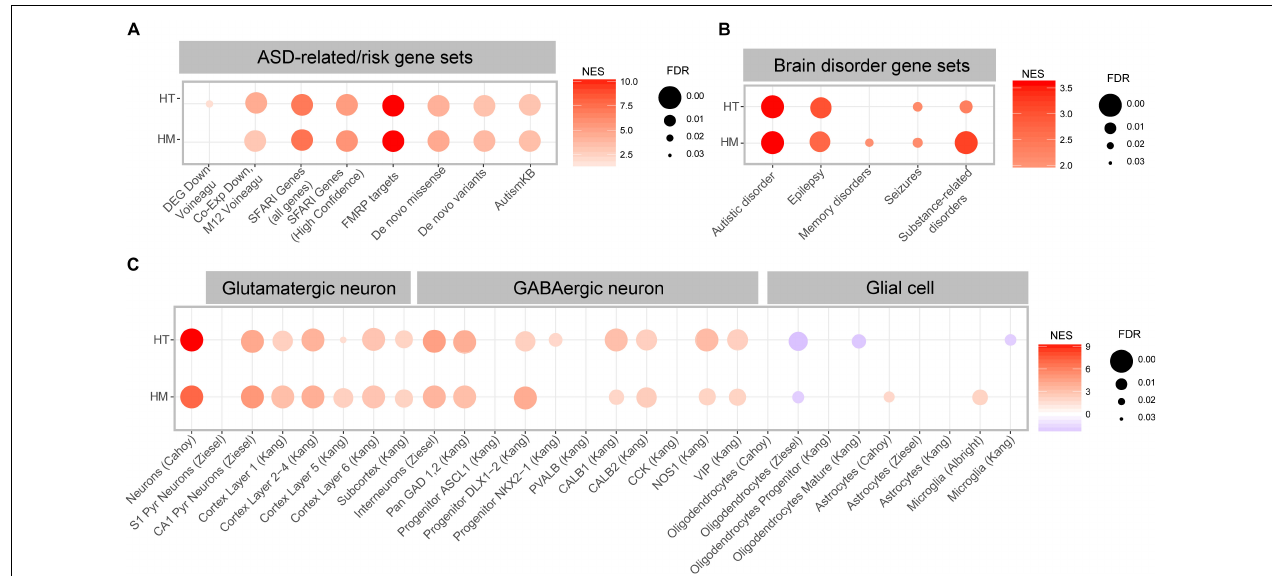
FIGURE 6 | ASD-related transcriptomic changes in Slc6a20a + / − and Slc6a20a − / − mice are revealed by GSEA. (A) GSEA results for transcriptomes from WT and Slc6a20a + / − mice (HT/WT transcripts) and WT and Slc6a20a − / − mice (HM/WT transcripts) for ASD-related gene sets (DEG_Down_Voineagu and Co-Exp_Down_M12_Voineagu) and ASD-risk gene sets (SFARI genes (all genes and high-confidence category 1 genes), FMRP targets, De Novo Missense, De Novo Variants, and AutismKB). See Supplementary Table 4 for further details on the GSEA results. NES, normalized enrichment score; FDR, false detection rate. (n = 4 mice for WT-HT, HT, WT-HM, and HM). (B) GSEA results for transcriptomes from WT and Slc6a20a + / − mice (HT/WT transcripts) and WT and Slc6a20a − / − mice (HM/WT transcripts) for gene sets in the DisGeNet (https://www.disgenet.org/). See Supplementary Table 4 for further details of the GSEA results. NES, normalized enrichment score; FDR, false detection rate. (n = 4 mice for WT-HT, HT, WT-HM, and HM). (C) GSEA results for transcriptomes from WT and Slc6a20a + / − mice (HT/WT transcripts) and WT and Slc6a20a − / − mice (HM/WT transcripts) for cell-type-specific gene sets. See Supplementary Table 4 for further details of the GSEA results. NES, normalized enrichment score; FDR, false detection rate. ( n = 4 mice for WT-HT, HT, WT-HM, and